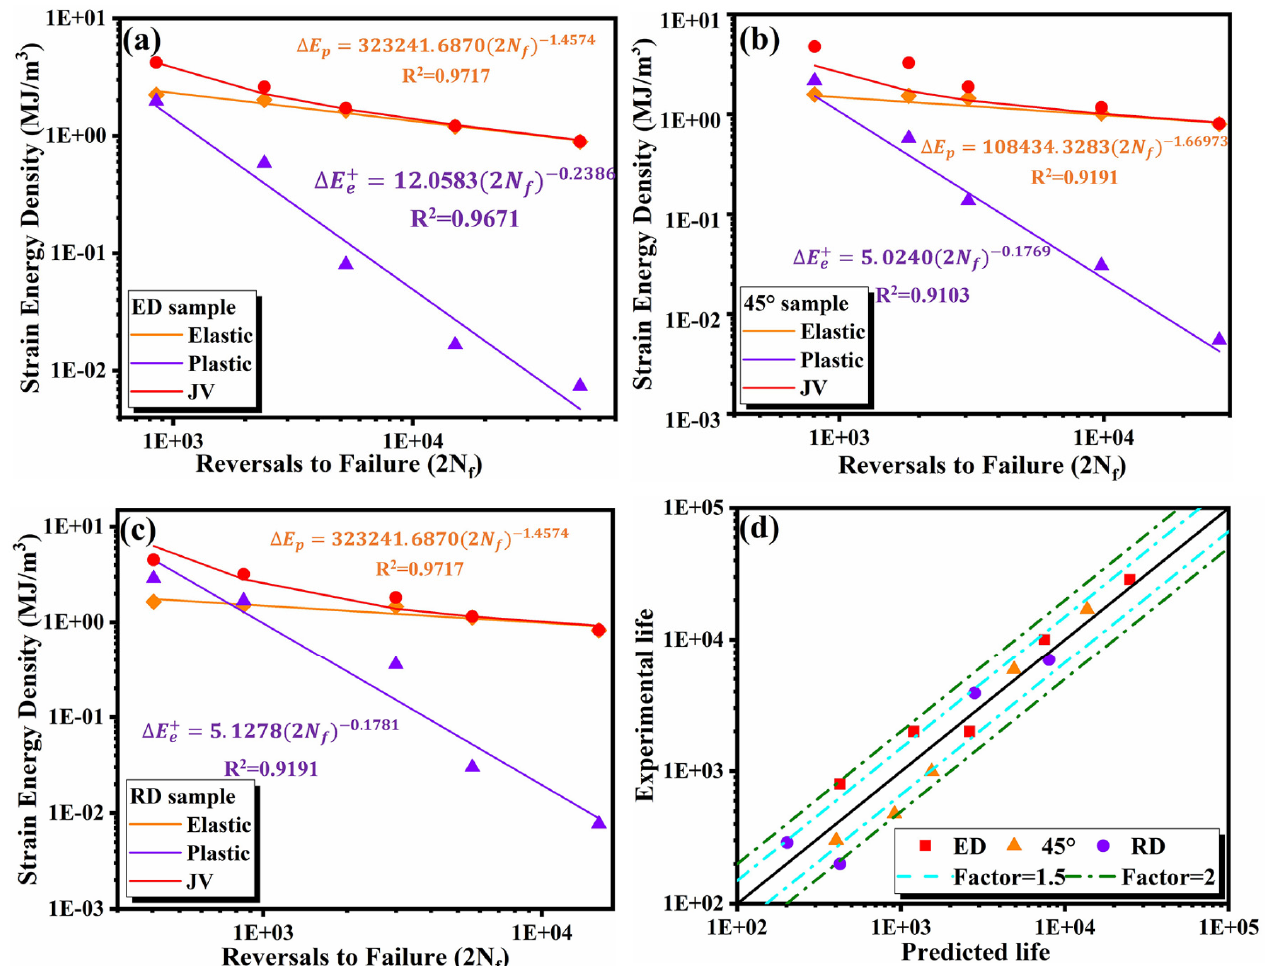
Figure 14. JV prediction model for ( a ) ED ( b ) 45 ◦ ( c ) RD ( d ) JV predicted vs. experimental life. Figures 13d and 14d show the comparison between the fatigue life predicted by the SWT and JV models and the experimental life of the three direction specimens, respectively. The solid diagonal line indicates a perfect match, while the blue and green dotted line indicates a deviation coefficient of 1.5 and 2 between the predicted life and the experimental life. Most data points gather at the boundary with a coefficient of 1.5, which shows that both models are suitable for the life prediction and analysis of extruded 7075 Al